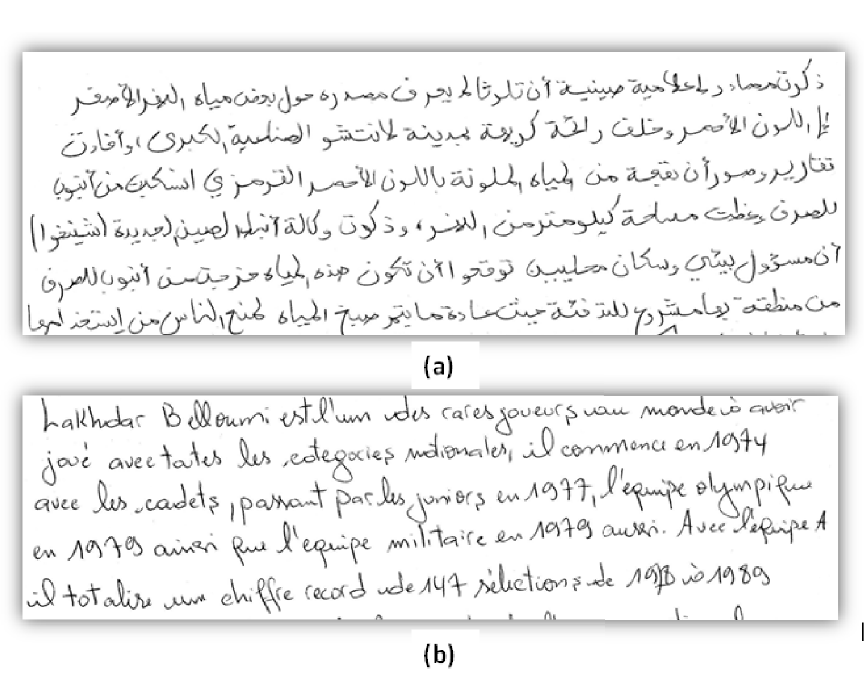
Fig. 2. some samples of the Arabic version (a) and the French version (b) of the LAMIS-MSHD